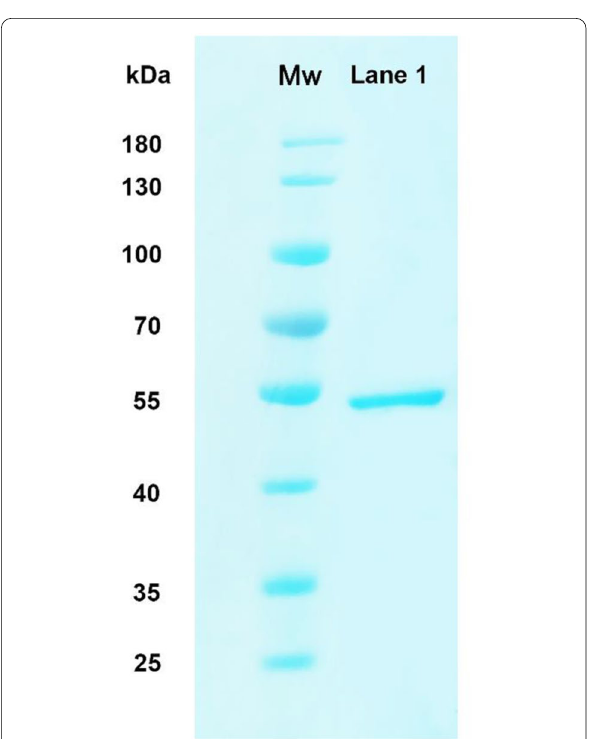
Fig. 4 The SDS-PAGE analysis of purified ErPelPL1. Lane left: molecular weight marker (Thermo Scientific, USA); lane 1: purified